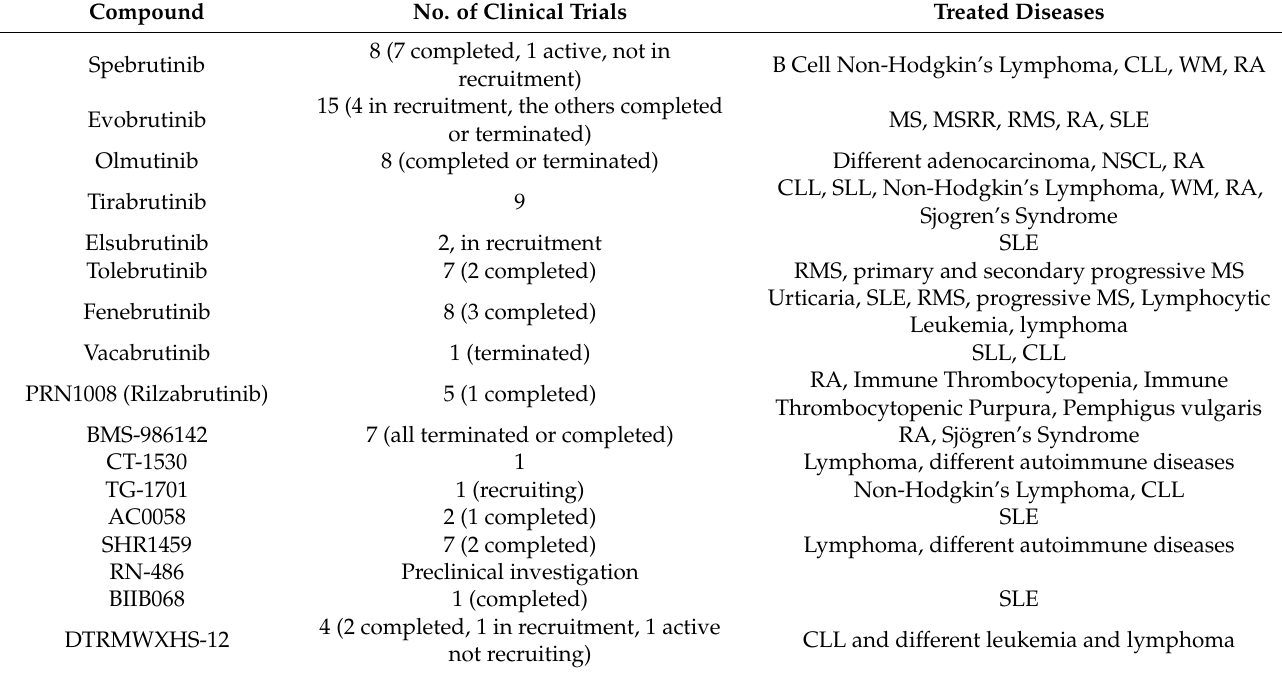
Figure 3. Irreversible BtkIs under clinical investigation. Table 2. BtkIs under clinical investigation, number of clinical trials and treated